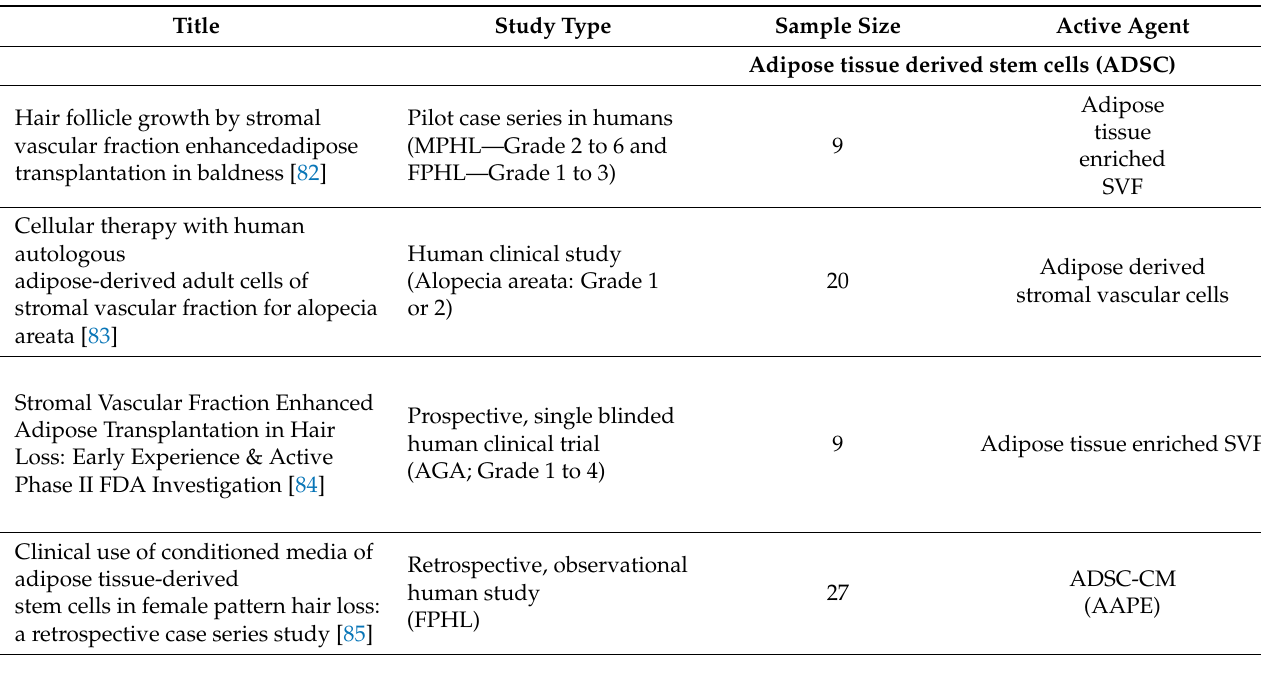
Table 2. Summary of studies on cellular therapies in hair